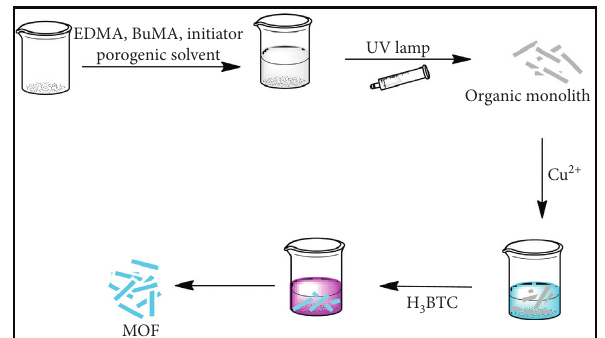
Figure 1: Steps of fabrication porous metal-organic (CuBTC-monopol) monolithic rod.